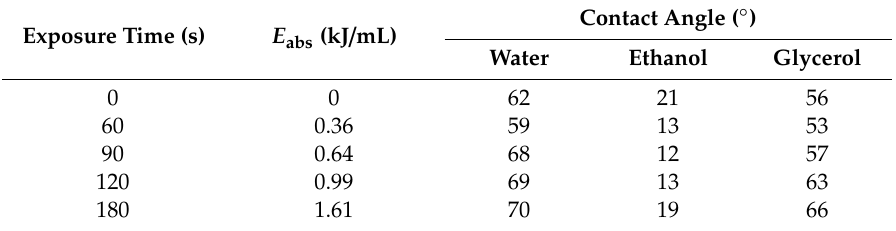
Table 3. The contact angles of water, glycerol, and ethanol for PVA foils obtained from aqueous solutions exposed to MWs for di ff erent times.